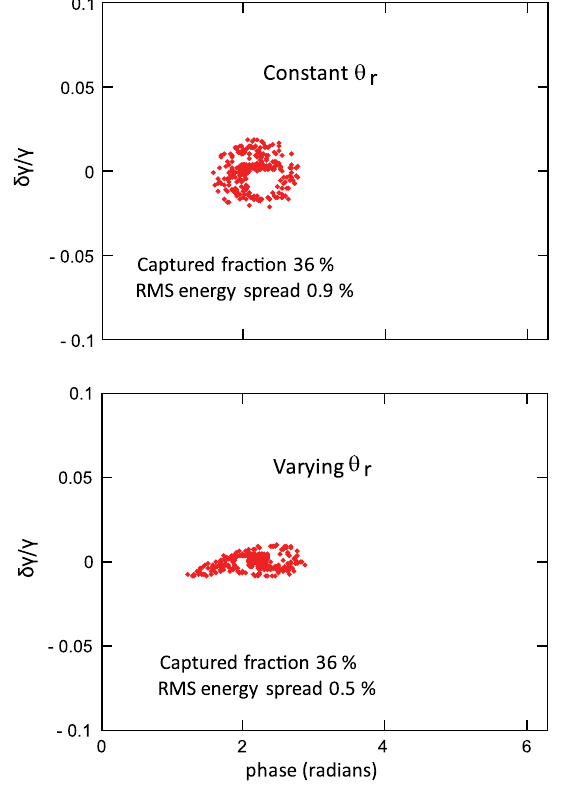
FIG. 4. Longitudinal phase space at the end of the undulator for the constant resonant phase and for the varying resonant phase undulator.